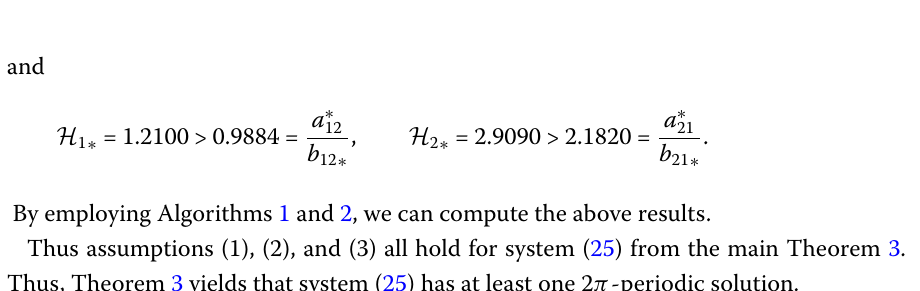
Figure 2 Graphics of b ij , where i , j = 1,2, in Example